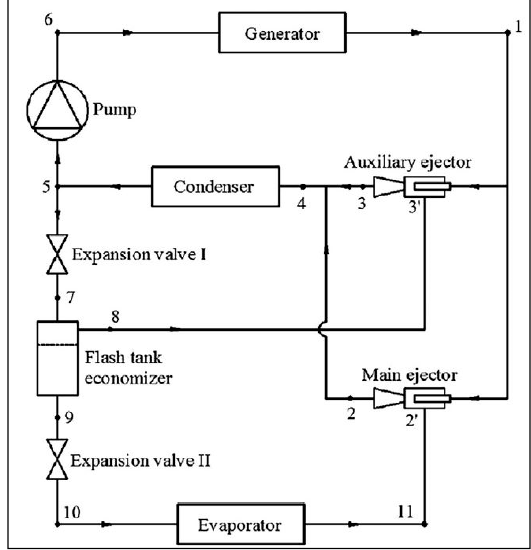
Figure 35. Enhanced ejector refrigeration cycle [333].